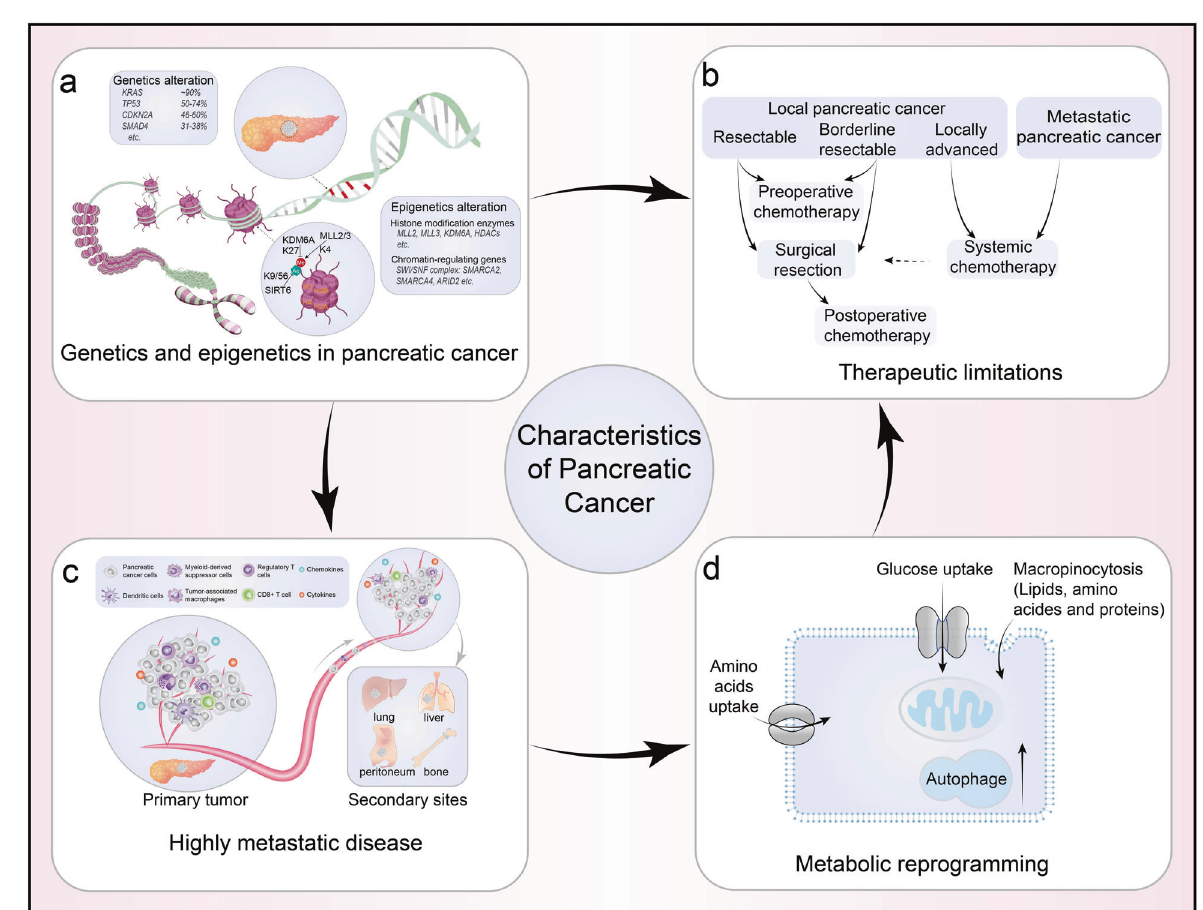
Fig. 1 The characteristics of pancreatic adenocarcinoma. Pancreatic cancer is a common cause of cancer mortality characterized by high heterogeneity, a dense stromal tumor microenvironment (TME), highly metastatic propensity, metabolic reprogramming, and limited bene fi ts from current conventional therapies. a Genetic and epigenetic changes in pancreatic cancer. KRAS (~90%), TP53 (50 – 74%), CDKN2A (46 – 60%), and SMAD4 (31 – 38%) are the most frequently mutated genes known to modulate the initiation and progression of pancreatic cancer. Epigenetic regulatory genes, including MLL2/3 , KDM6A , and multiple HDACs encoding genes, regulate histone modi fi cation. SMARCA2/4 and ARID2 modulate chromatin remodeling. b Therapeutic limitations in pancreatic cancer. Surgical resection is the only potentially curative choice for pancreatic cancer patients. Adjuvant chemotherapy can only partially improve the overall survival of pancreatic cancer patients c Pancreatic cancer is an extremely aggressive tumor with high metastatic propensity. The immunosuppressive TME plays an important role in modulating the metastasis of pancreatic cancer cells to the liver, lungs, peritoneum, and bone. d Metabolic reprogramming of pancreatic cancer. Pancreatic cancer cells can survive and proliferate in stressful microenvironments by reprogramming energy metabolism to increase glucose and glutamine uptake, macropinocytosis, and autophagy GDP-bound inactive form. Clinical studies have also shown that genesis and progression of pancreatic cancer, including gene KRAS mutations could be considered as a marker for the poor expression changes, copy number aberrations, chromosomal prognosis of pancreatic cancer. 17 However, it has been reported rearrangements, and epigenetic alterations (Fig. 1a). Pancreatic cancer typically starts as a precancerous lesion, i.e., a pancreatic that various KRAS mutations affect diverse signaling pathways, intraepithelial neoplasia (PanIN), which accumulates gene muta- leading to distinct functional consequences. Pancreatic cancer tions over time, ultimately progressing to a more dysplastic patients with KRAS at codon 61 mutations exhibit lower state. 16 – 18 Approximately 90% of pancreatic cancers of all grades extracellular signal-regulated kinase (ERK) activation compared with patients with other KRAS alleles, and the former harbor have activating oncogenic Kirsten rat sarcoma viral oncogene signi fi cantly better prognosis. 19 – 21 It is evident that KRAS mutation homolog ( KRAS ) mutations. Among the oncogenic KRAS mutations associated with pancreatic cancer in humans, the GAT (aspartic seems to be necessary but not suf fi cient for pancreatic cancer acid; G12D), GTT (valine; G12V), and TGT (cysteine; G12C) mutations are the most common, while the CGT (arginine (Arg); G12R) and GCT (alanine; G12A) mutations as well as other point mutations at codons 11, 13, 61, or 146 appear to be less common. 17,18 As the most common activating mutations in pancreatic cancers have inactivating mutations in the tumor suppressor gene TP53. 16,23 TP53 inactivation impairs DNA damage pancreatic cancer, KRAS mutations (which have also been investigated in depth in various other cancers, including meta- recognition and blocks cell cycle arrest, allowing cells to bypass static colorectal cancer and non-small cell lung cancer) impair the cell cycle checkpoints and evade apoptotic signals. 16,23 Mutations intrinsic GTPase activity of KRAS and prevent GTPase-activating in CDKN2A , which can lead to loss of regulation of the cyclin- proteins (GAPs) from converting the active GTP-bound form to the dependent kinase (CDK) 4 and CDK6 cell cycle checkpoints and, Signal Transduction and Targeted Therapy (2021)